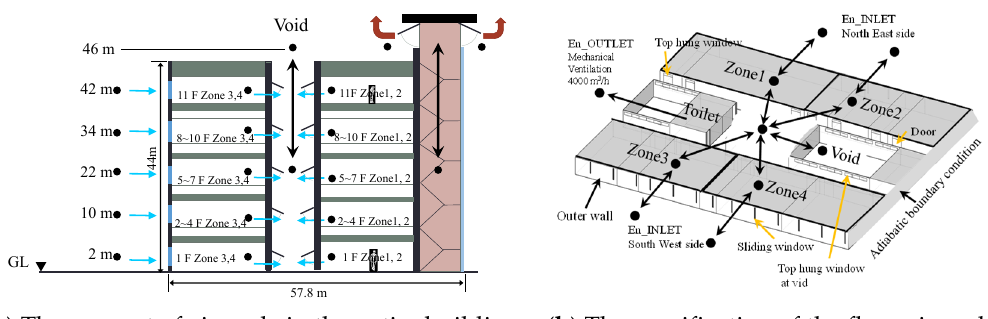
Figure 6. Simplified building model and the plan of the network simulation in the buildings: ( a ) the connect of air node in the entire building; ( b ) the specification of the floor air node.